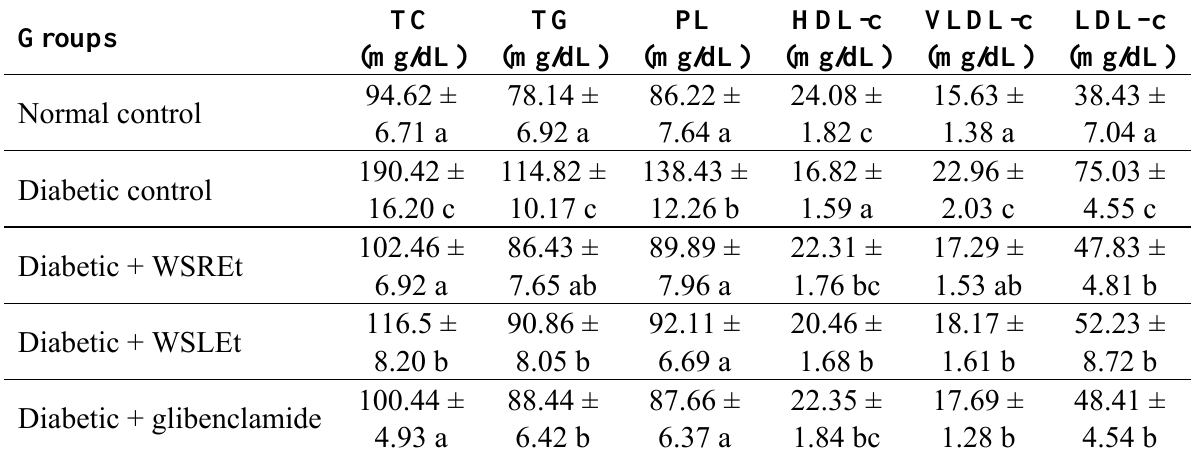
Table 4. Effects of W. somnifera (L.) extracts on serum lipid